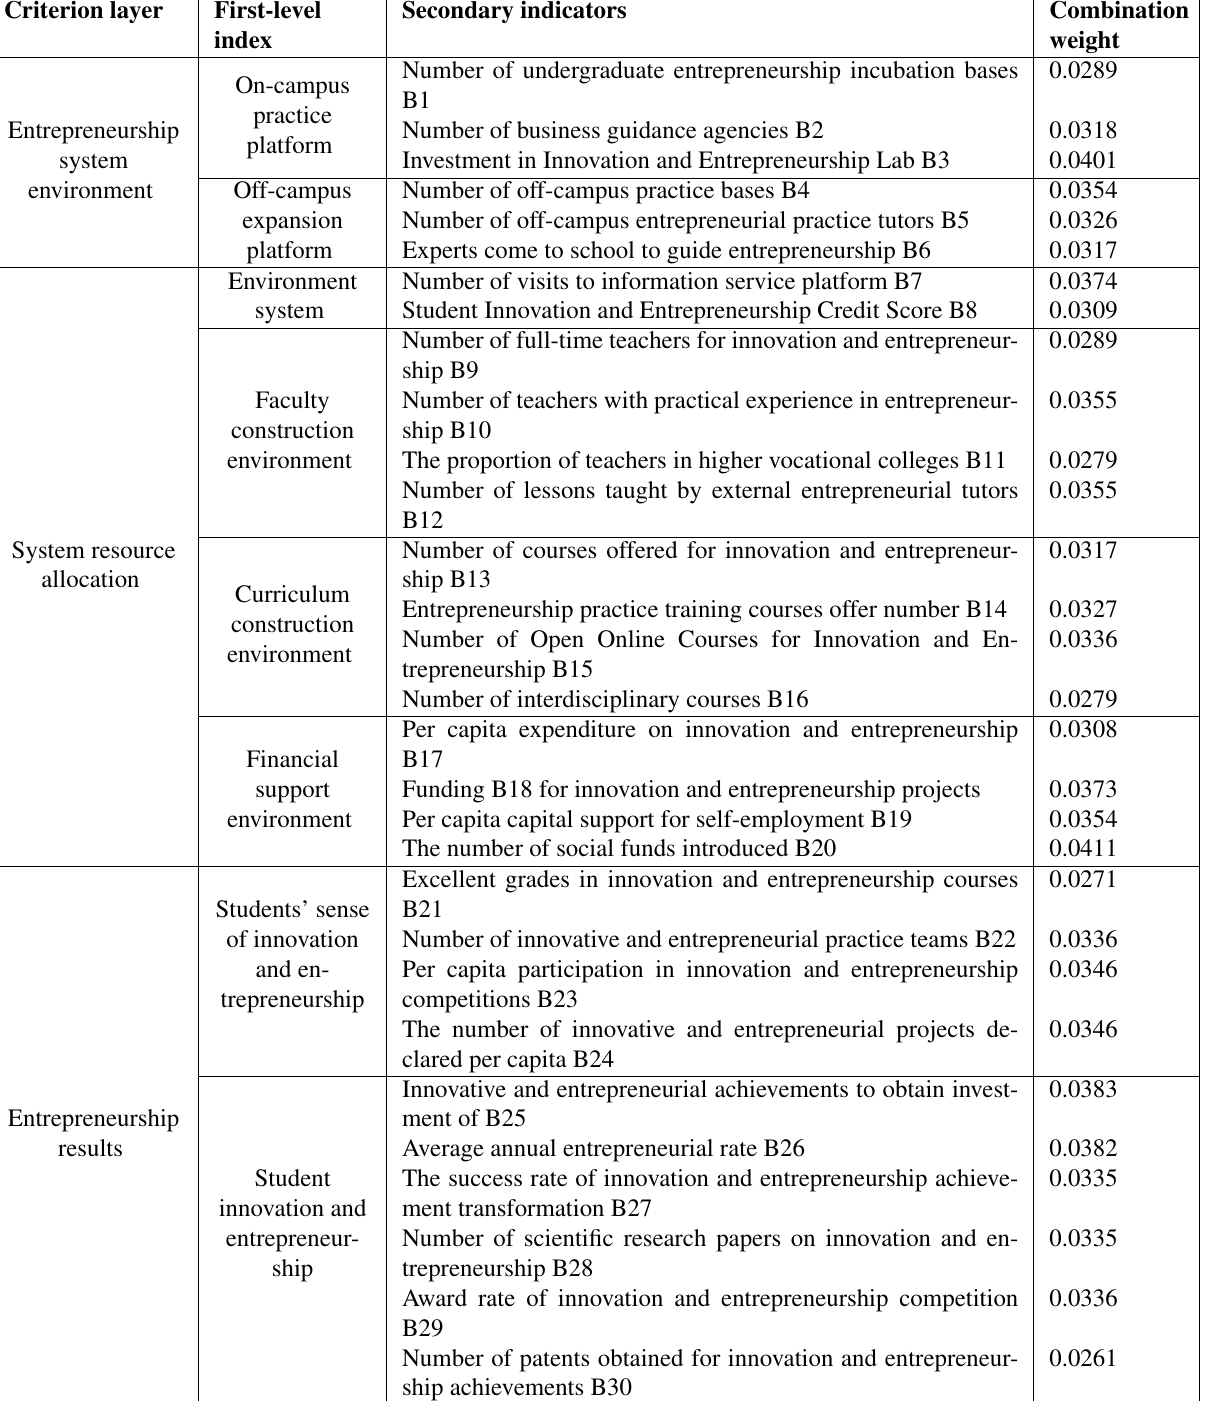
Table 1 Ecological environment evaluation index system and weight coefficient of university innovation and entrepreneurship